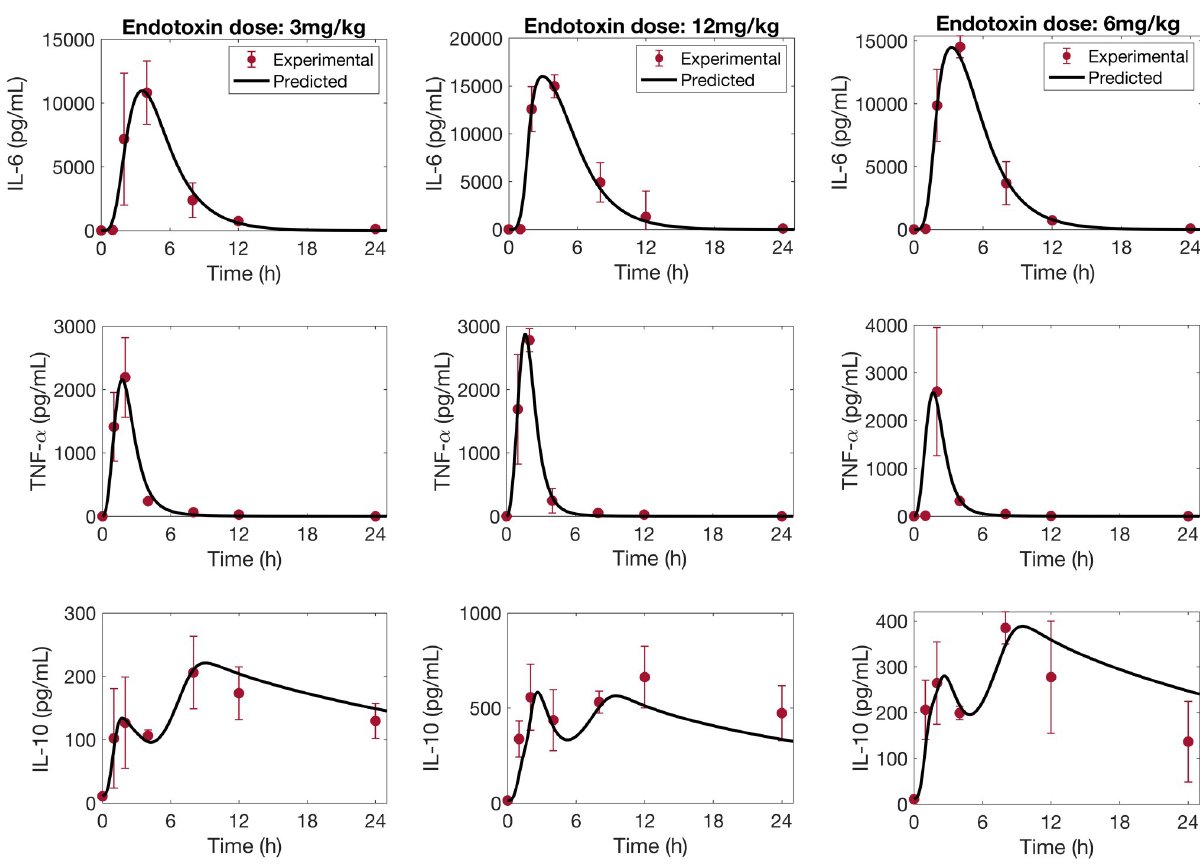
Fig 4. Predicted cytokine time profiles. Comparison of predicted time-courses of IL-6, TNF- α and IL-10 (solid line), against experimental data (circle) (mean ± SD), in response to endotoxin challenge at dosages of 3 mg/kg, 12mg/kg and 6mg/kg.